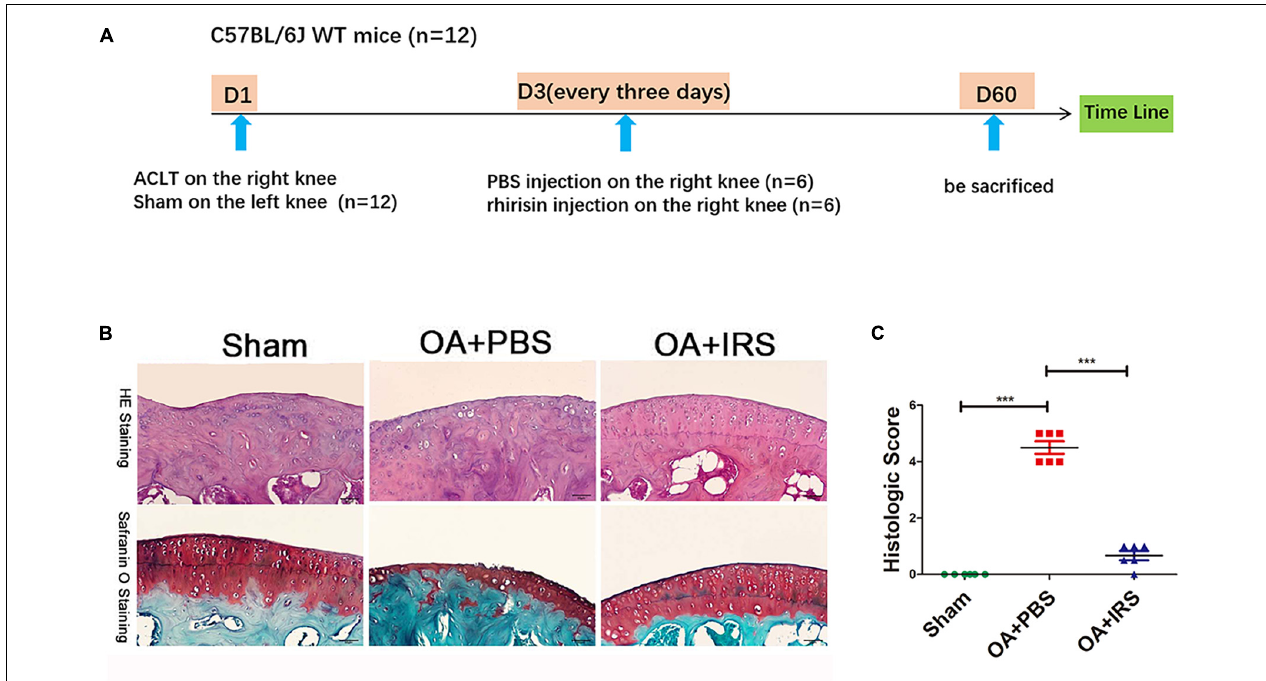
FIGURE 2 | Irisin can significantly inhibit cartilage degradation. (A) Timeline of recombinant irisin (r-IRS)/PBS intraarticular injection on anterior cruciate ligament transection (ACLT) mice model. (B) Cartilage of OA mice (C57BL/6J wide type mice with ACLT-model, n = 6) exhibited significant erosion compared with sham operated mice (C57BL/6J wide type mice, n = 6). When intraarticular injected with irisin, mouse cartilage erosion was inhibited (H&E staining and safranin-O staining). (C) Histologic score of mouse joints shows OA mice suffer significant erosion, which can be rescued with irisin injection. *** p < 0.001.